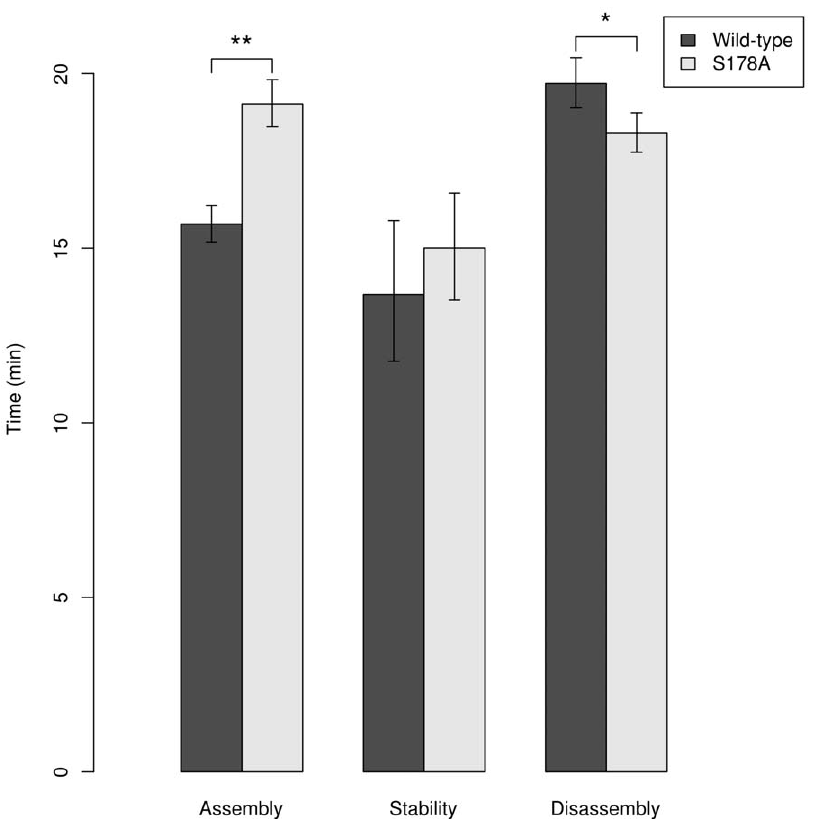
Figure 8. The lengths of the assembly and disassembly phases in S178A mutant FAs are significantly different from those in the wild-type, while the stability phase lengths are unaffected. The phase length values include all adhesions where the log-linear models fit with a p-value of 0.05 or less. Error bars indicate 99% confidence intervals on the mean phase length as determined through 50,000 bootstrap samples. A double asterisk (**) indicates p , 10 2 5 and single asterisk (*) indicates p , 0.05. Wild-type N Values: Assembly (1068), Stability (465), Disassembly (1392); S178A N Values: Assembly (2106), Stability (870), Disassembly (1802).